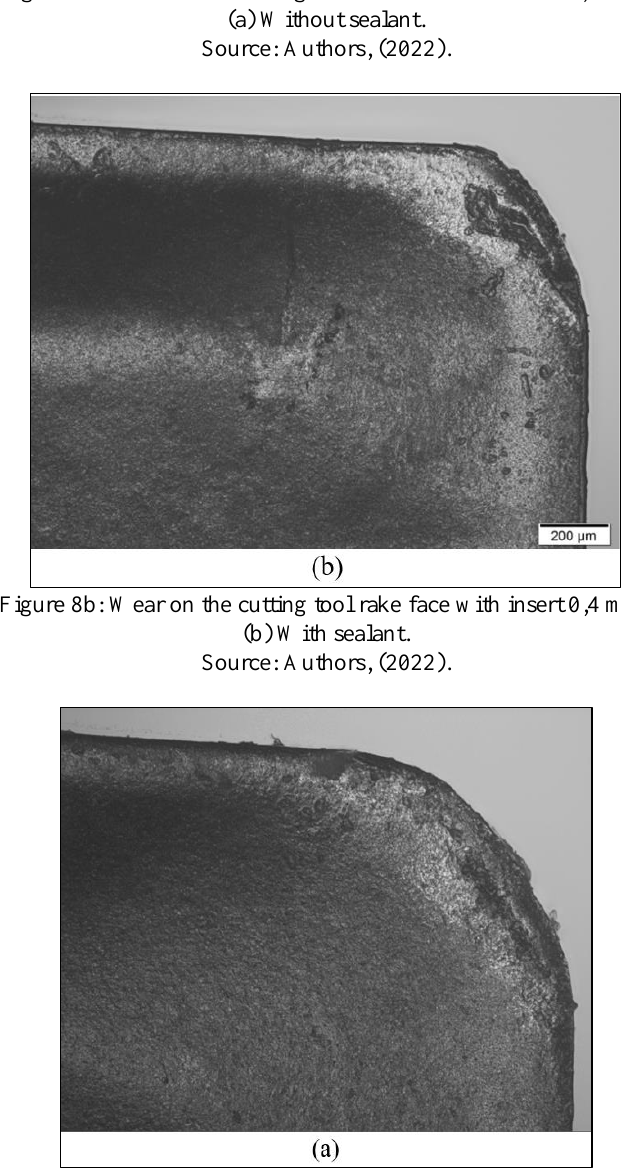
Figure 6b: Wear on the secondary flank with insert 0,4 mm: (b) With sealant.